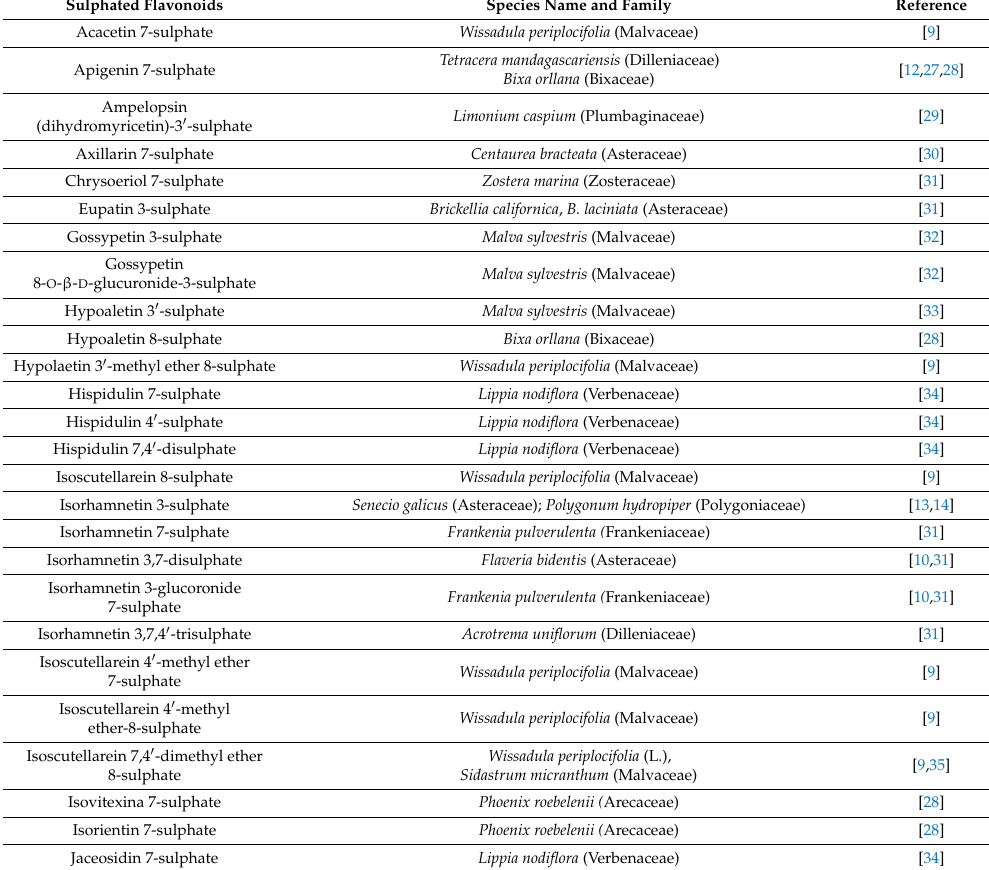
Table 1. Sulphated flavonoids reported from plants and their sources (species name and family). Sulphated